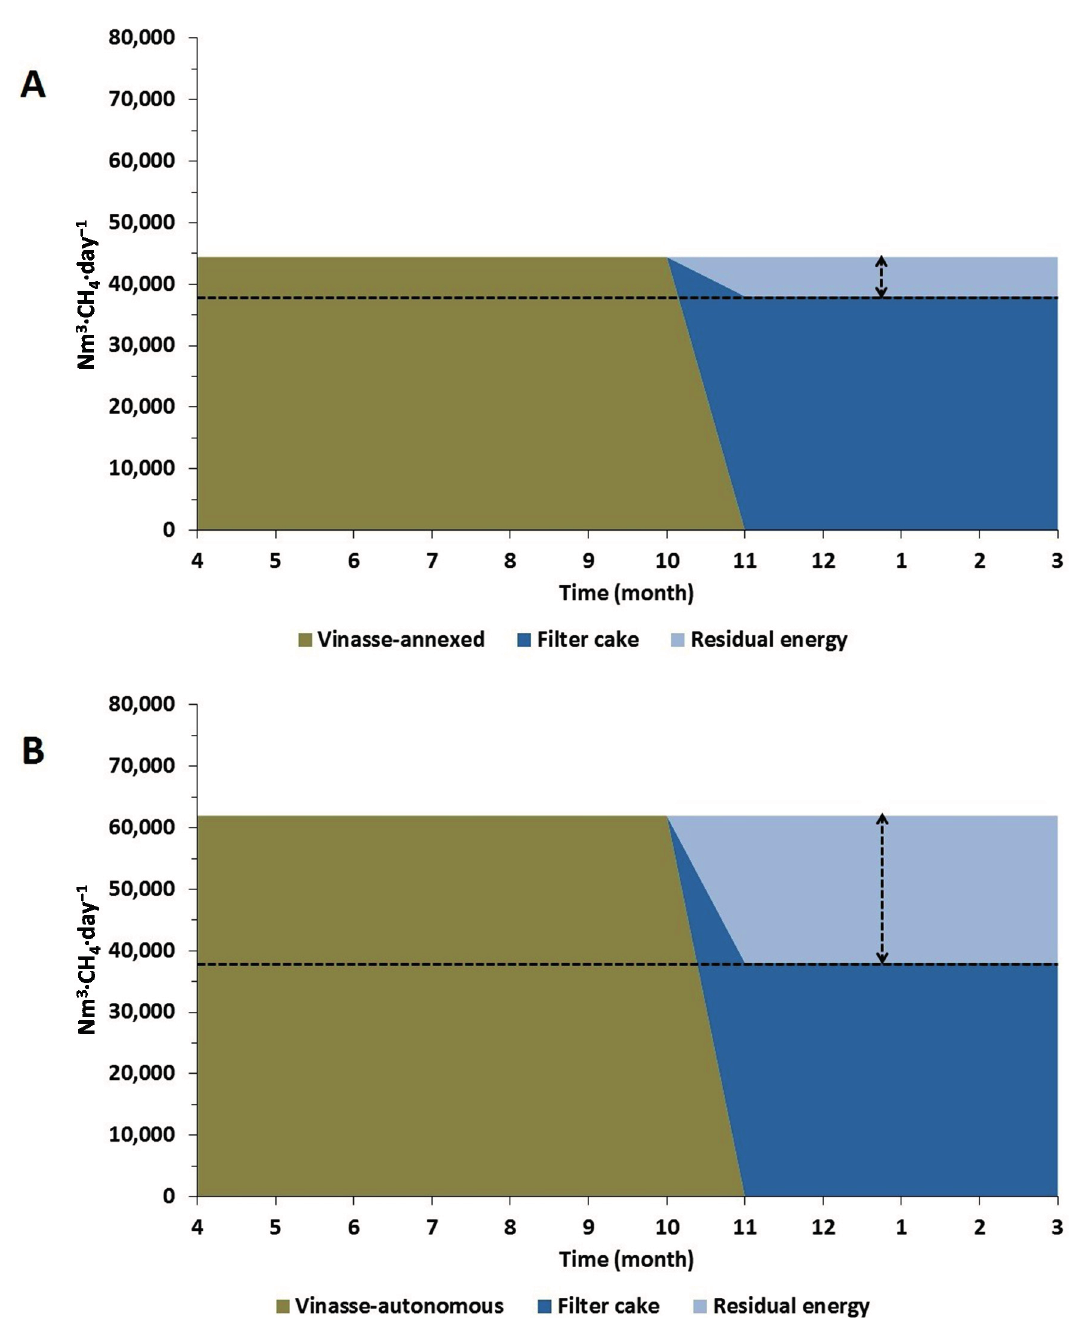
Figure 3. Energy potential of the vinasse and filter cake calculated for a hypothetical sugarcane plant. ( A ) Energy potential according to an autonomous sugarcane plant; ( B ) Energy potential according to an annexed sugarcane plant. Residual energy (highlighted by the dotted lines) is the difference in daily methane production between the potential energy of vinasse and filter